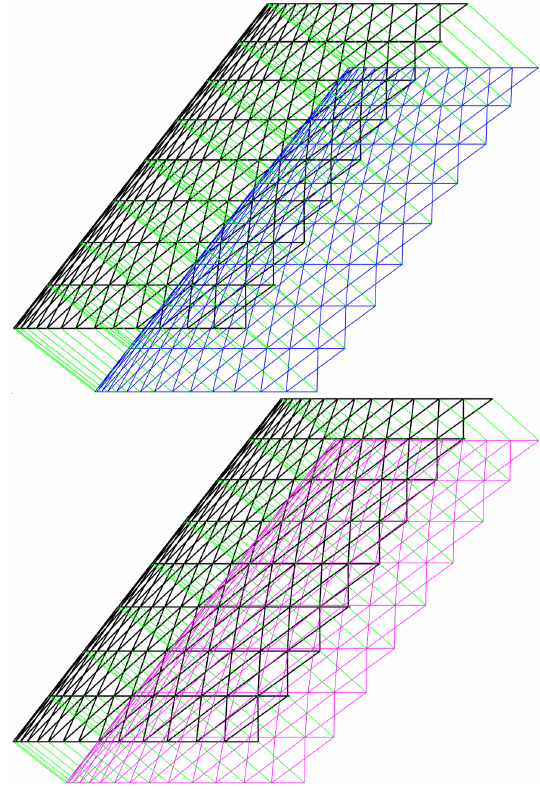
Figure 5: Fragment of the double-layer lattice dome of the shape based on the two-sheet rotational hyperboloid